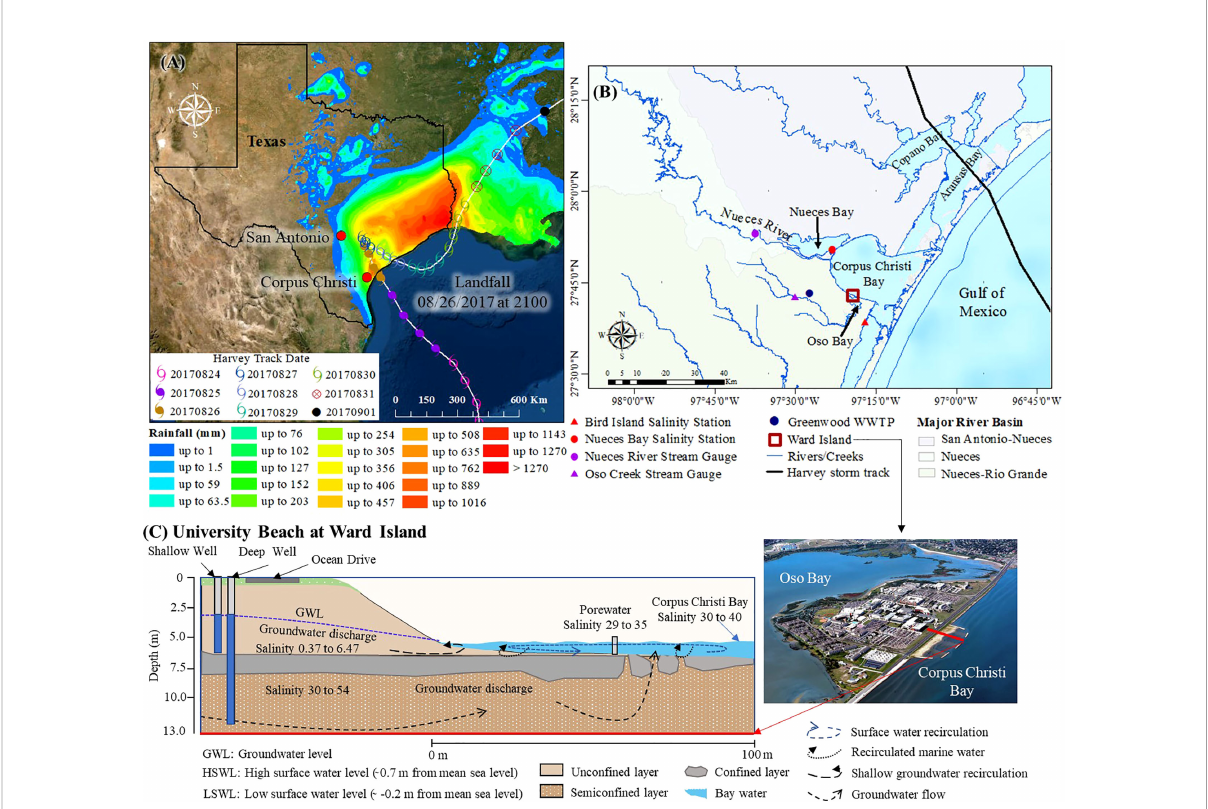
FIGURE 1 (A) The Hurricane Harvey path and Saf fi r – Simpson Hurricane Wind Scale categories (Blake and Zelinsky, 2018) and precipitation totals. (B) The geographic location of the study area with major river basins, stream gauges (Nueces River at Calallen, TX [08211500], and Oso Creek at Corpus Christi [08211520]), salinity stations (Nueces Bay [NUDE3, 043] and Bird Island [NPSBI, 171]), wastewater treatment plants (WWTP), and Harvey storm track shown. Samples were collected from the Texas A&M University-Corpus Christi beach on Ward Island (University Beach). (C) Overhead view of Ward Island (credit: TAMUCC MARCOM, CC BY-SA 4.0) showing the location of the sampling transect for the vertical cross- sectional representation of the study site with the sampling locations of groundwater and porewater shown. Surface water was collected in line with the groundwater and porewater within 10 m of the